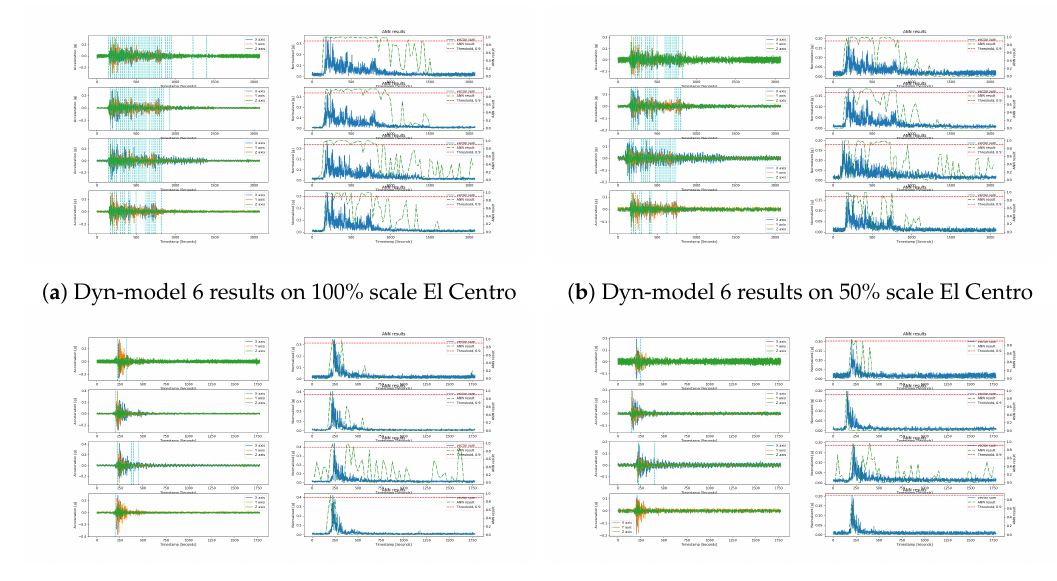
Figure 11. Dyn-model 6 test results on the El Centro earthquake of scale 100% (left-top) and scale 50% (right-top); Model test results on the Pohang earthquake of scale 100% (left-bottom) and scale 50% (right-bottom); the results are ordered from top to bottom for each subfigure’s sensor, namely ADXL355, LIS3DHH, MMA8452, and MPU9250.